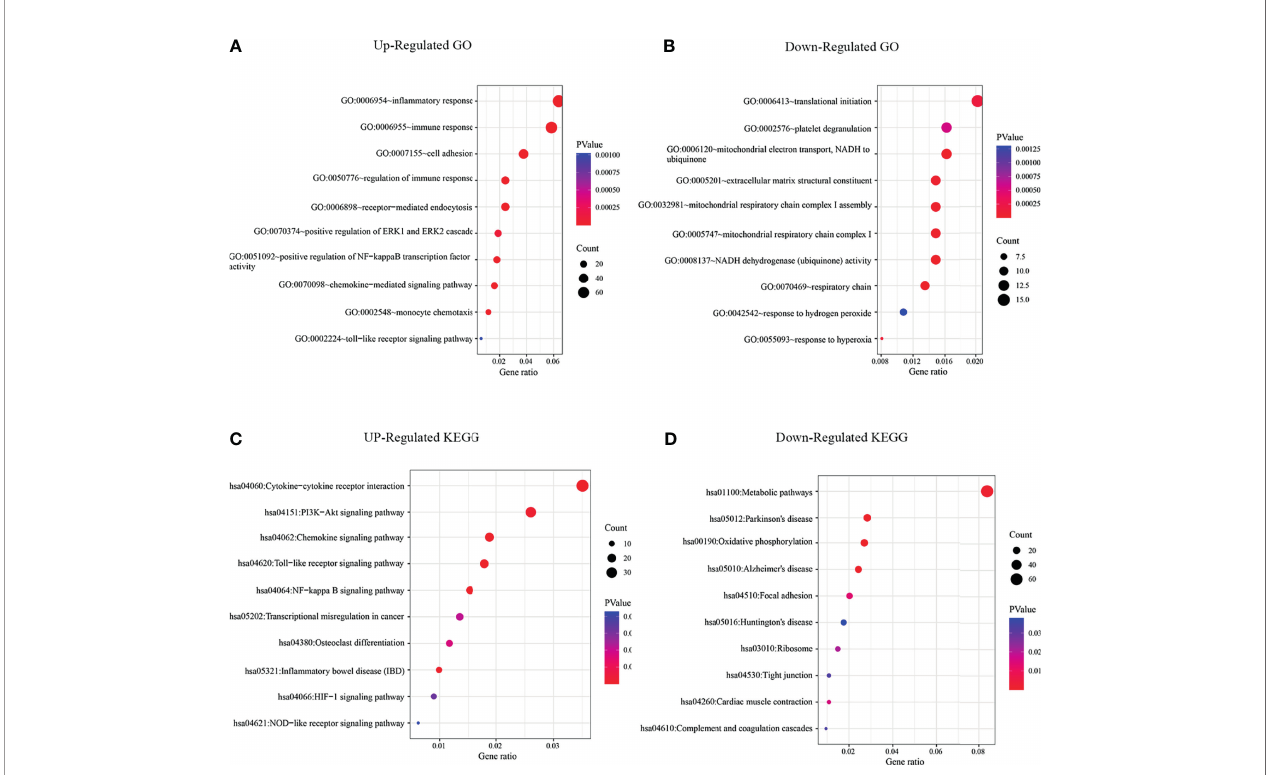
FIGURE 3 | KEGG and GO enrichment analysis revealed that signi fi cant enrichments of immune signaling pathways in CSF-1R high TAMs. (A) GO analysis of up- regulated signaling pathways in CSF-1R high TAMs versus CSF-1R low TAMs. (B) GO analysis of down-regulated signaling pathways in CSF-1R high TAMs versus CSF- 1R low TAMs. (C) KEGG analysis of up-regulated signaling pathways in CSF-1R high TAMs. (D) KEGG analysis of down-regulated signaling pathways in CSF-1R high